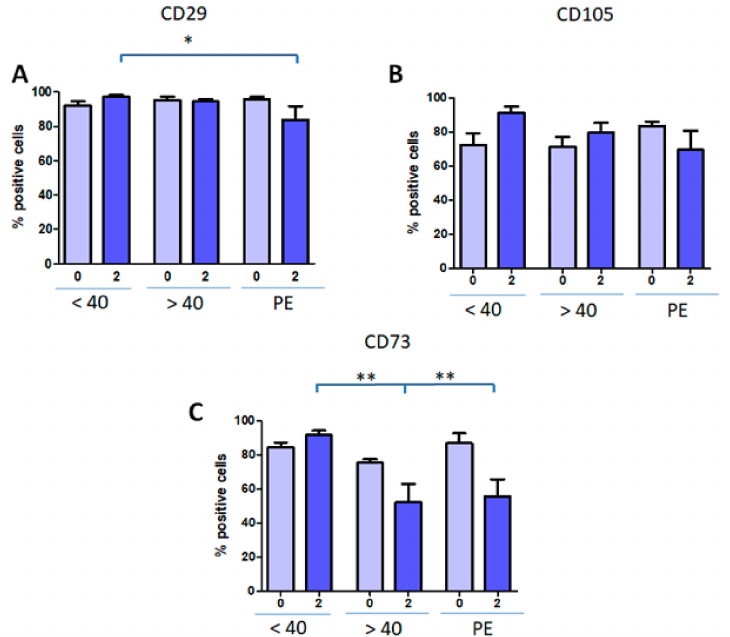
Figure 3. Mesenchymal marker expression in hAMSCs from all Groups. hAMSCs were evaluated for CD29 ( A ), CD105 ( B ), CD73 ( C ) markers at isolation (p0) and p2 by flow cytometry. Results are expressed as mean ± SD of triplicates for each isolate (Group 1, n = 7; Group 2, n = 6; Group 3, n = 5). * P < 0.05; ** P < 0.01.